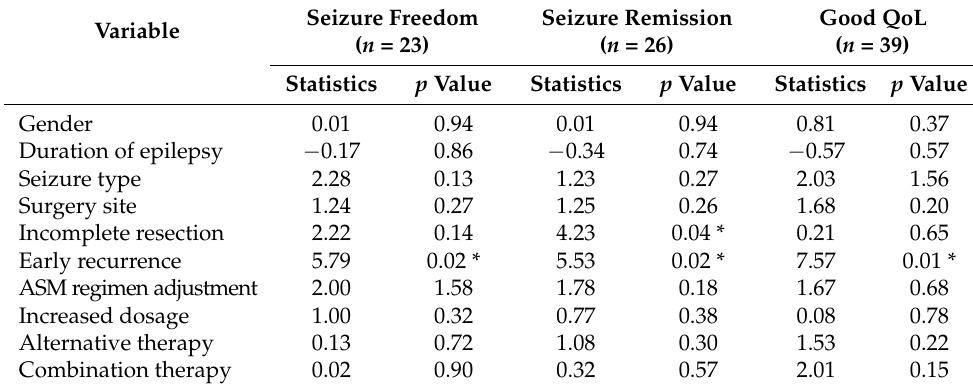
Table 2. Association between clinical variables and outcome in children with failed resection